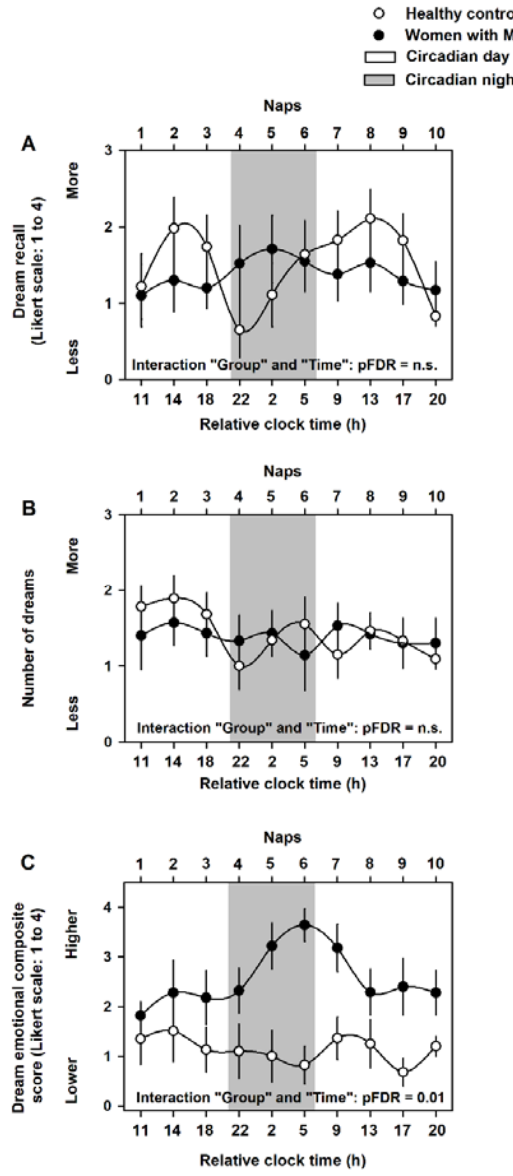
Figure 2. Dream recall, number of dreams and dream emotional composite score levels during the 40 h multiple nap protocol. We observed no significant interaction effects of “Group” and “Time”